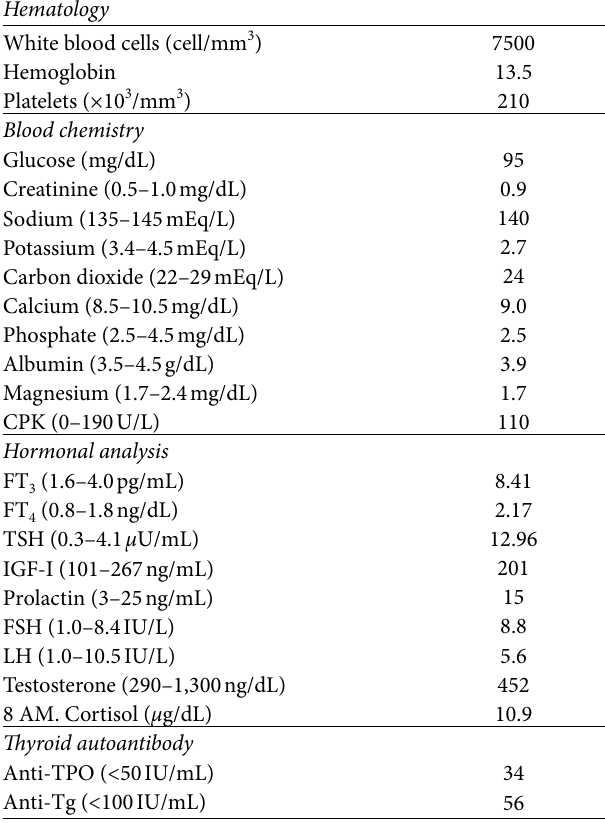
Table 1: Laboratory data on admission.